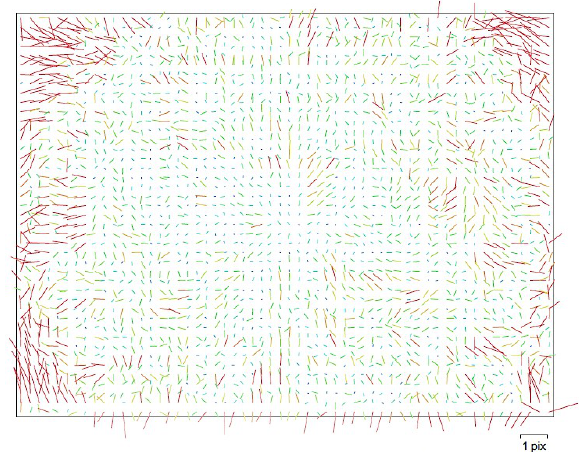
Figure 5. The example of distortion distribution after self- calibration process on undistorted images